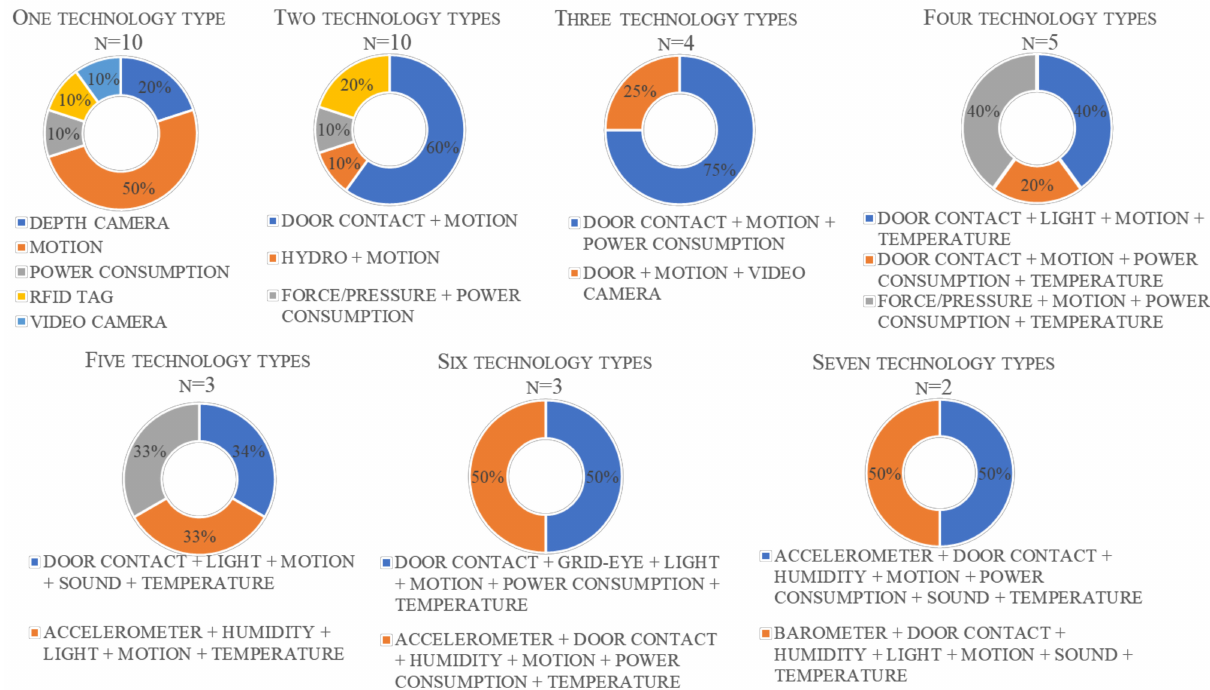
Figure 4. Combination of technology types used within the environment only system category; n denotes the number of systems using the specified number of technology types, with the technology combinations shown below each